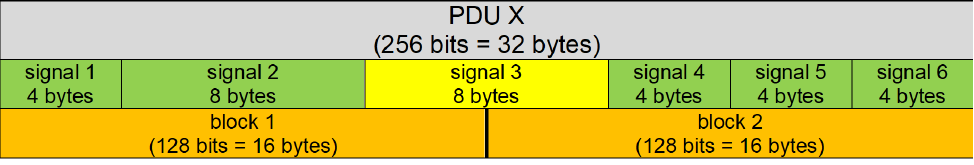
Figure 7. Signal spans over two consecutive blocks.